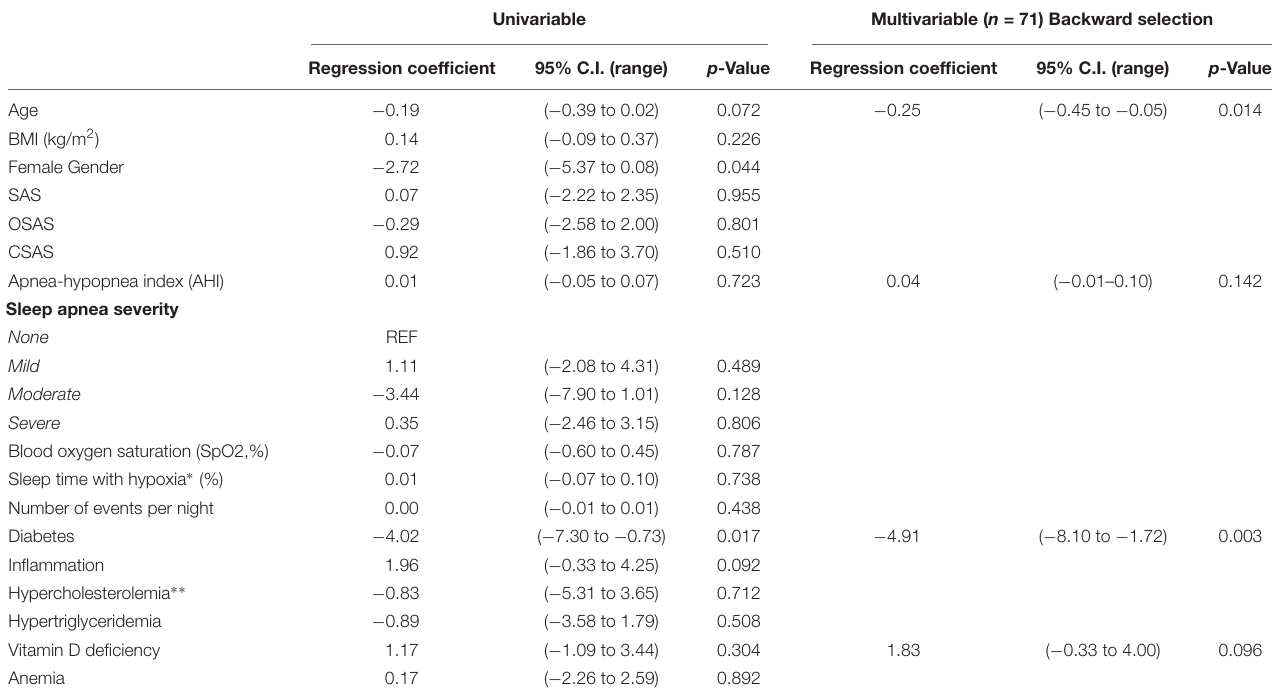
TABLE 4 | Uni- and Multi-variable regression to identify factors associated with the Mini Mental State Exam